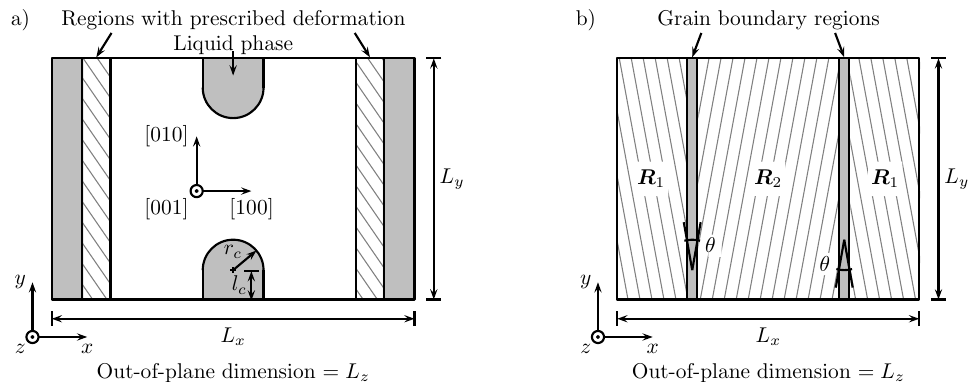
Figure 1. Schematic illustration of the two 3D PFC simulation models. ( a ) Model 1: Notched sample subject to prescribed deformation. The deformation is applied in the hatched regions by an external force field described using Equations (8) and (9). Liquid regions are defined along the left and right domain edges to permit use of periodic boundary conditions, as required by the spectral solution scheme. ( b ) Model 2: Domain with two crystals having orientations R 1 and R 2 , separated by symmetrical tilt grain boundaries with tilt angle θ